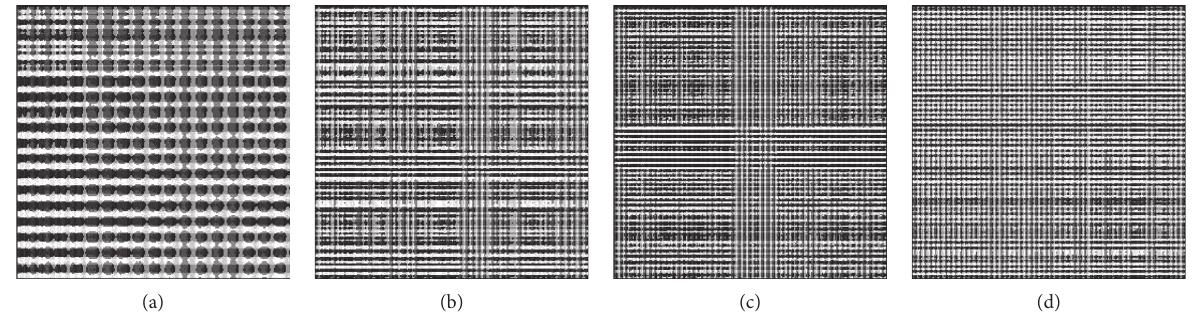
Figure 9: GTM sample: (a) normal state; (b) inner ring fault; (c) outer ring fault; (d) rolling body